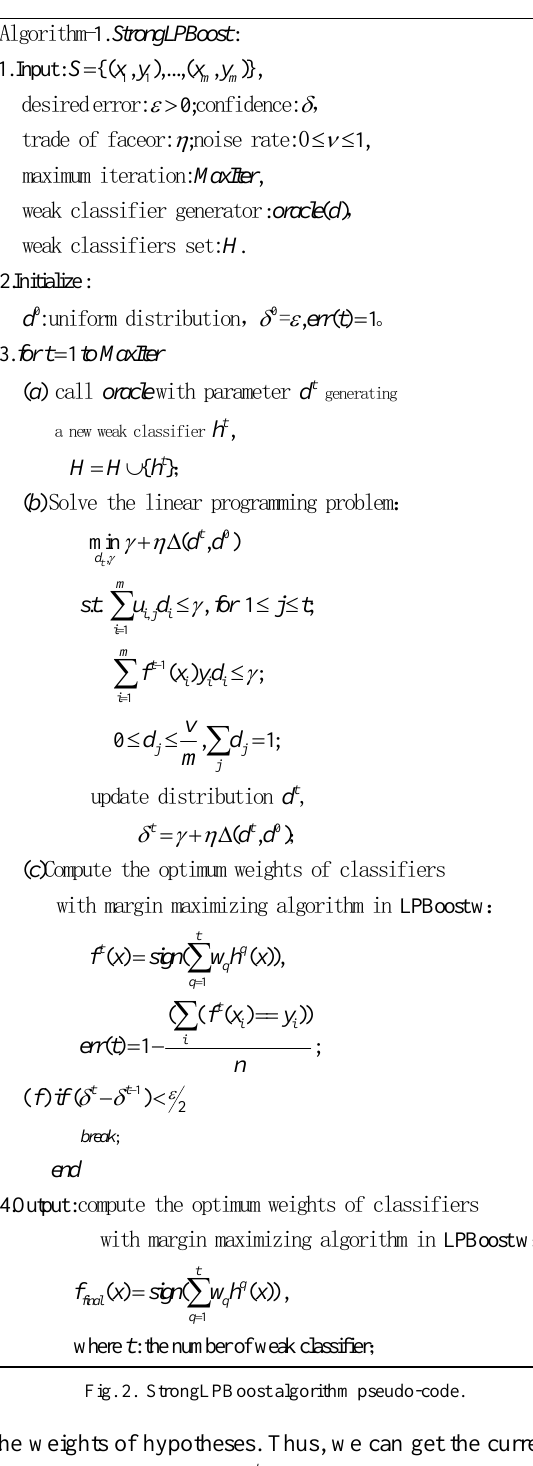
Compute the optimum weights of classifiers with margin maximizing algorithm in